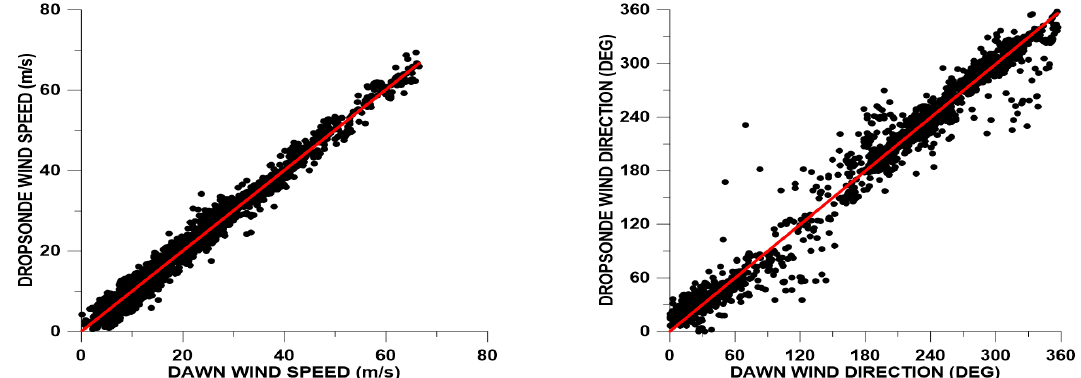
Figure 4. Scatterplots of DAWN–dropsonde comparisons of wind speed ( left ) and wind direction ( right ) for PW2. Table 6. Quantitative comparisons of DAWN and dropsonde wind speed and wind direction during PW2 as subsetted by height (top) and DAWN wind speed (bottom).